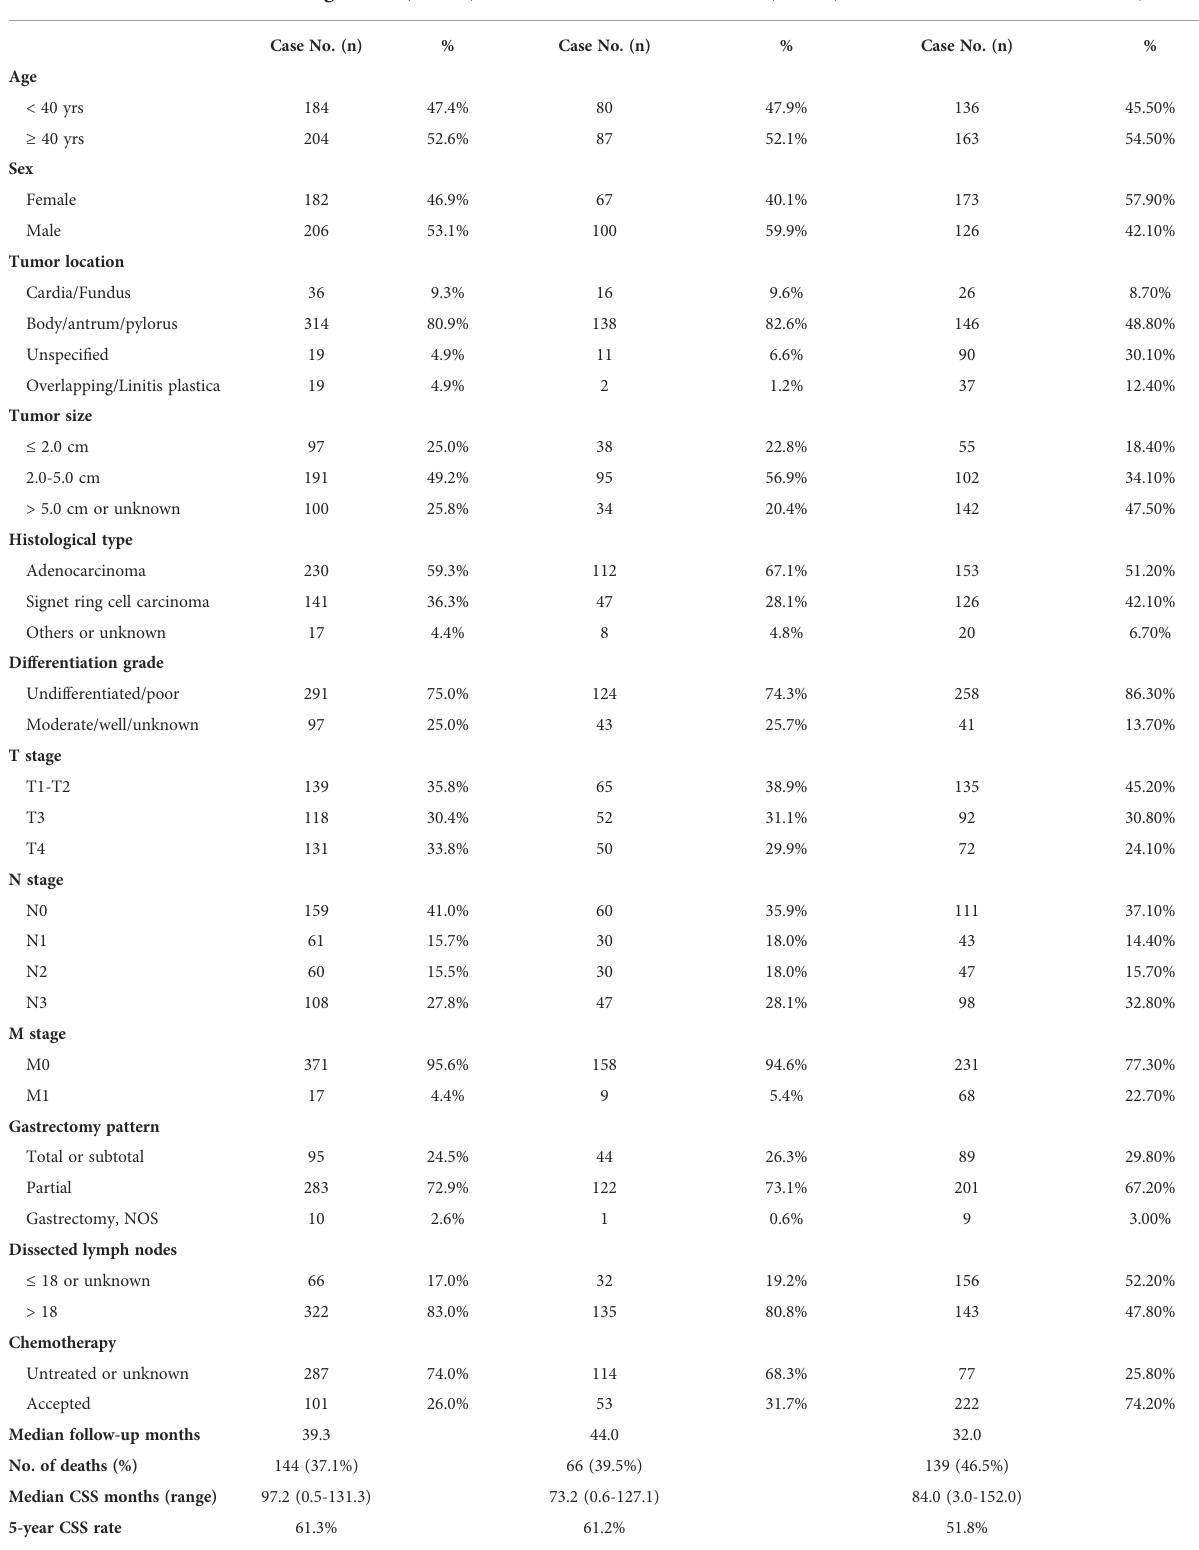
TABLE 1 Demographic and clinicopathologic characteristics of the training and validation